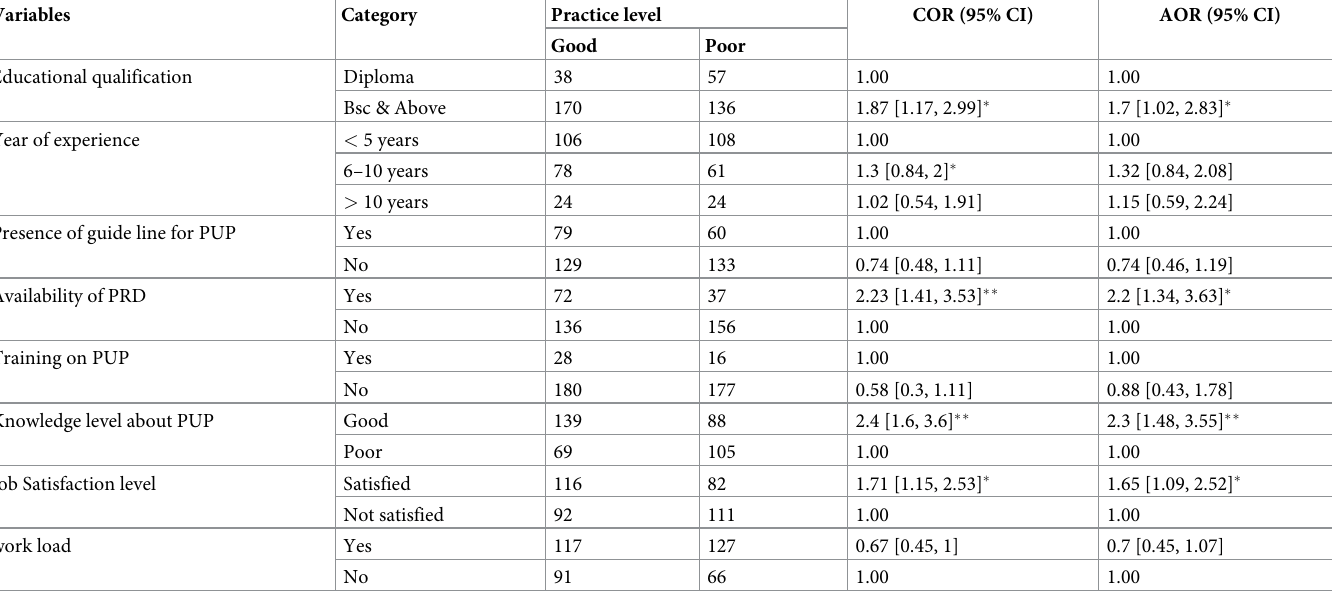
Table 5. Bivariate and multivariable analysis result for factors associated with pressure ulcer prevention practice among nurses working in public hospitals of Har- ari regional state and Dire Dawa city administration, Eastern Ethiopia, 2018 (n = 401). Variables Category Practice